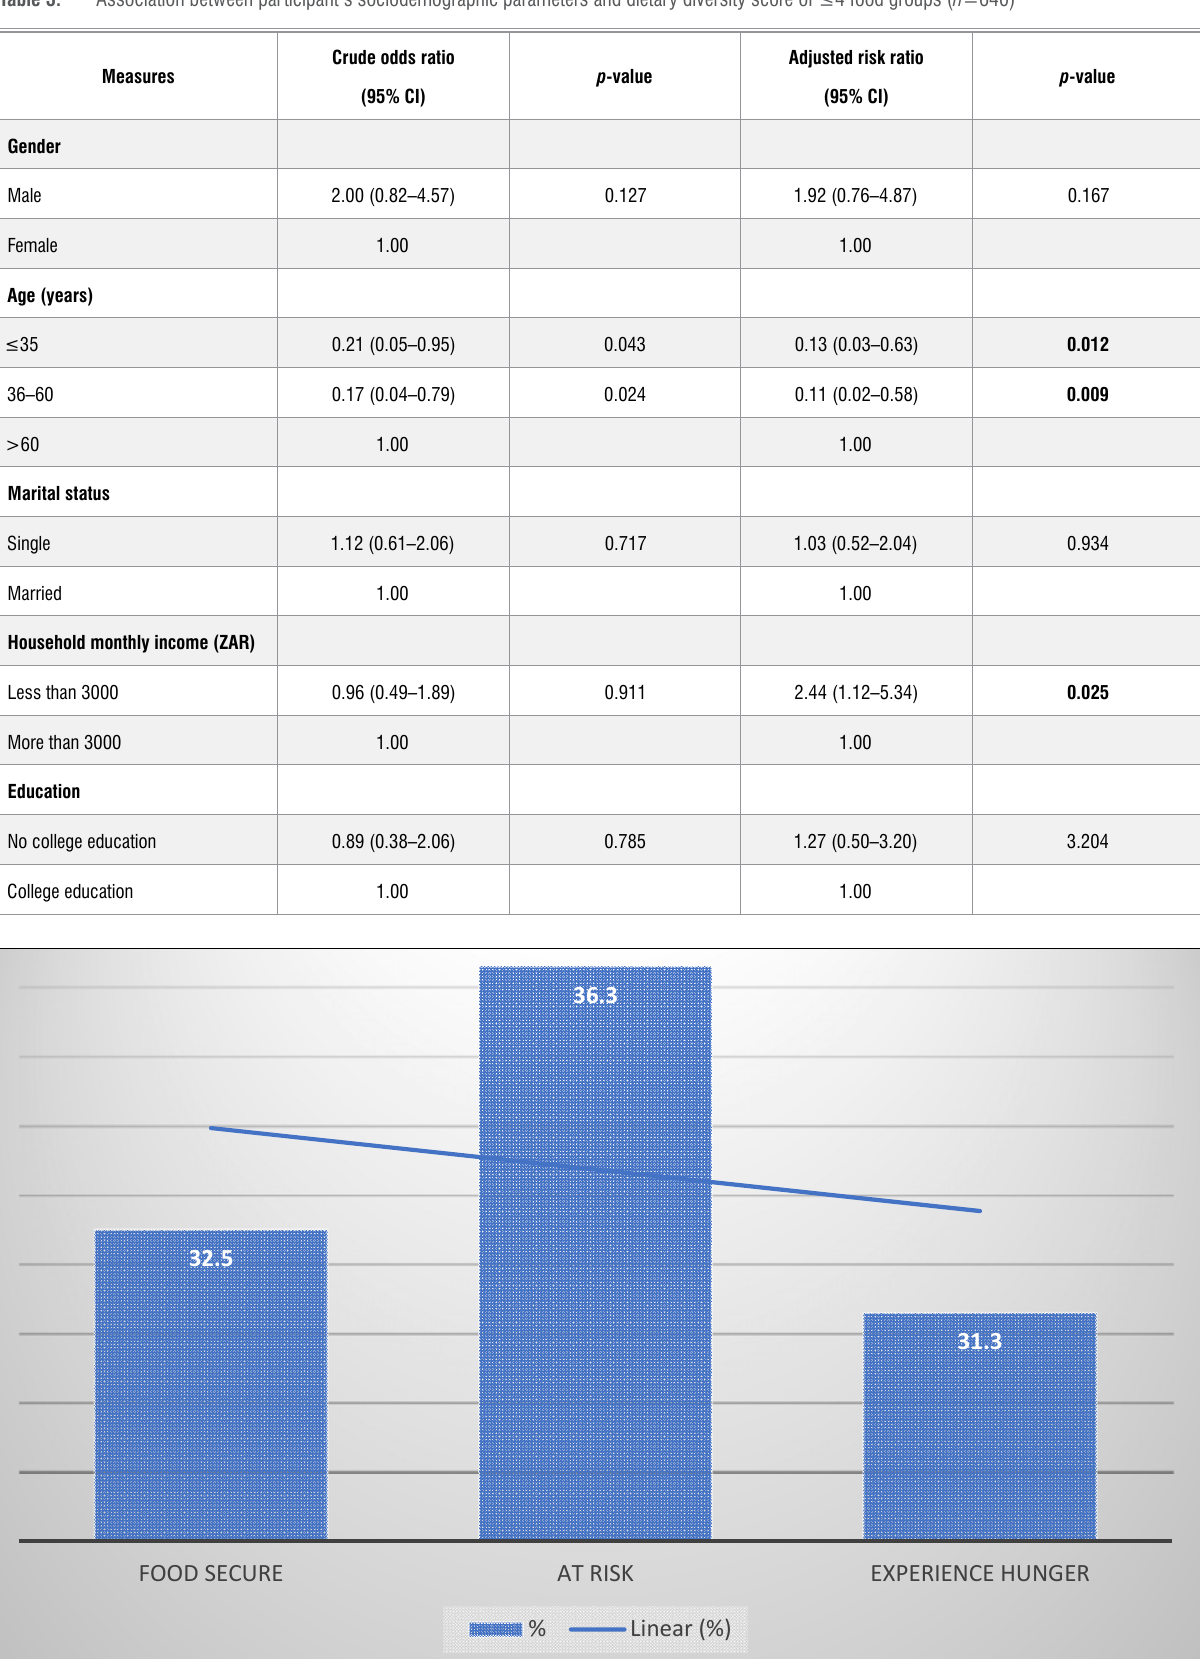
Figure 3: Household food security status.